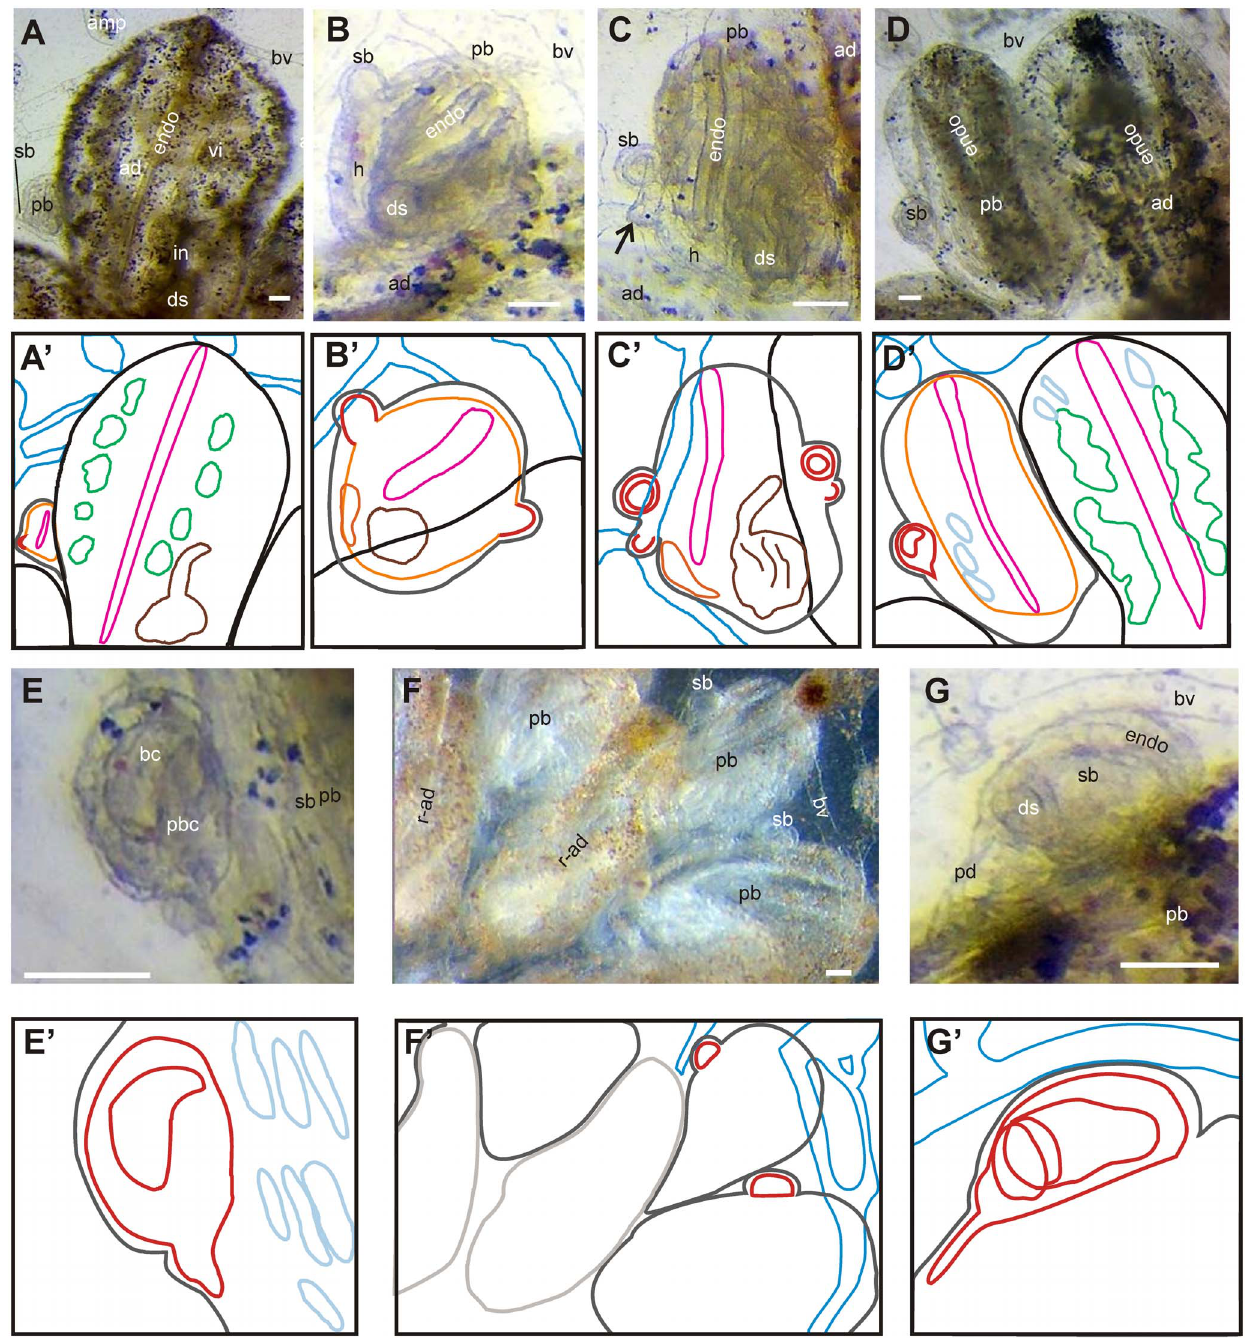
Figure 6. Blastogenesis in B.schlosseri . A–G. Ventral views of colonies ( i.e. , ventral views of adults and primary buds, lateral views of secondary buds). A’–G’. Sketches of images A–G; black lines, adult epidermis; dark gray lines, bud and budlet epidermis; pale gray lines, regressing adult epidermis; red lines, budlet; yellow lines, branchial and peribranchial chambers in bud; orange, heart; pink, endostyle; green, ventral cell islands in adult; brown, gut; dark blue, blood ampullae and vessels in tunic; pale blue, stigmata. A. Adult zooid, primary and secondary buds of a colony at colonial stage 9/7/1. The primary bud (stage 7/1) has almost completed organogenesis; the secondary buds (stage 1) is recognizable as a thickening of the atrial wall of the primary bud. B. Primary and secondary buds of a colony at stages 9/8/2 are outlined. C. In stage 8/3, the heart beats in the primary bud and forms a closed sphere in the secondary bud (stage 3) that will soon begin, at stage 4 (not shown), a series of invaginations reminiscent of gastrulation. Note a small secondary bud at stage 2 (arrow) posterior to the bud at stage 3 (which determines the stage of the colony). D, E. Colonial stage 9/8/5 characterized by growth of the primary bud and organogenesis in the secondary bud (enlarged in E). F, G. In colonial stage 11/8/6, adult zooids shrink and are reabsorbed by means of apoptosis, while the primary buds mature and replace them. G: enlargement of the secondary bud. ad, adult zooid. amp, ampulla; bc, branchial chamber; bv, blood vessel; ds, digestive system; endo, endostyle; h, heart; pb, primary bud; pbc, peribranchial chamber, r-ad, resorbing adult zooid; sb, secondary bud; vi, ventral cell islands. Scale bars-100 m m.